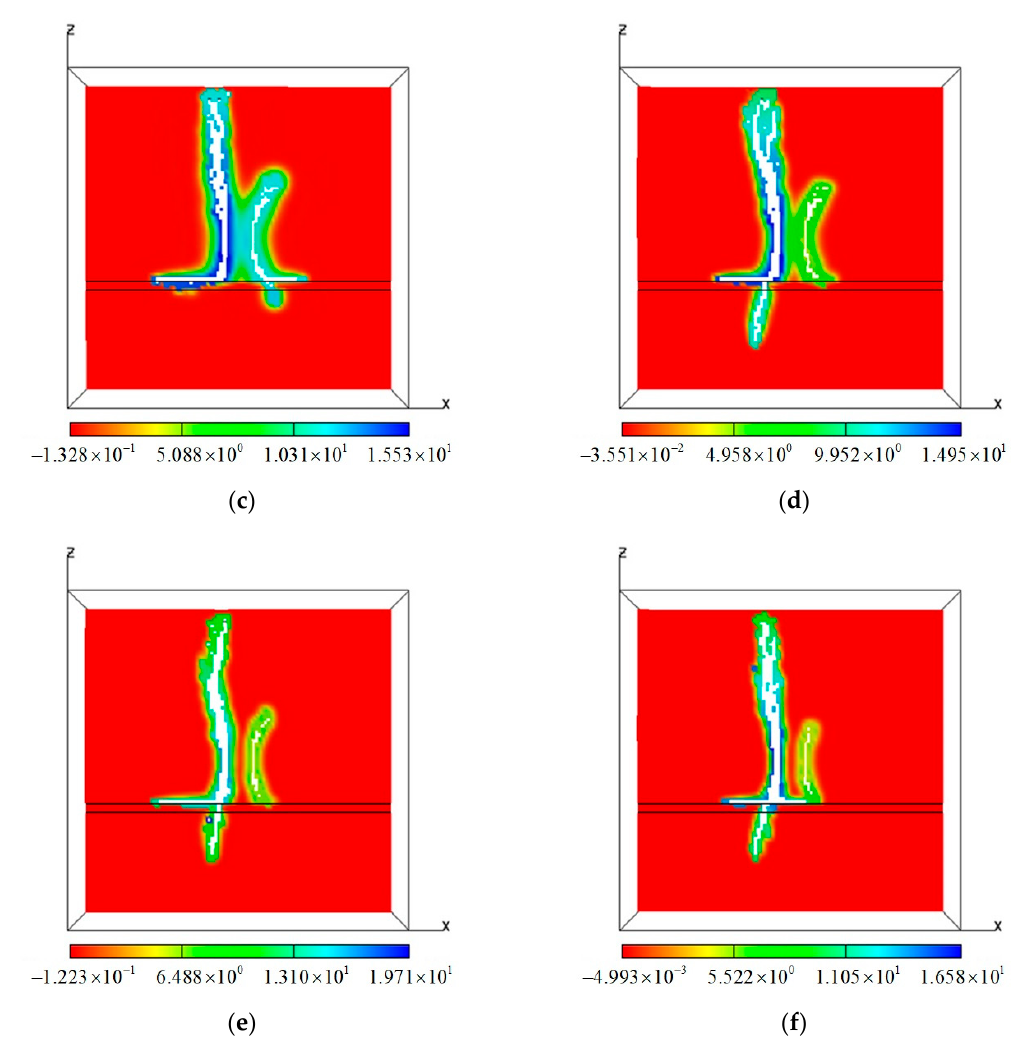
Figure 19. The seepage fields (MPa) of models with different hydraulic fluid viscosity when the primary fractures reach the boundary: ( a ) Multi-vis1, t = 1160 s, μ 1 / μ 0 = 0.2; ( b ) Multi-vis2, t = 1650 s, μ 2 / μ 0 = 0.5; ( c ) Multi-01, t = 2120 s, μ 0 / μ 0 = 1.0; ( d ) Multi-vis3, t = 2322 s, μ 3 / μ 0 = 2.0; ( e ) Multi-vis4, t = 2491 s, μ 4 / μ 0 = 4.0; ( f ) Multi-vis5, t = 2750 s, μ 5 / μ 0 = 6.0.